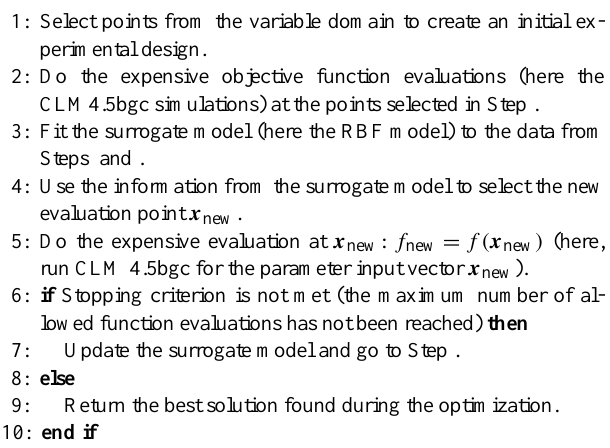
Algorithm 1 General surrogate global optimization algo-